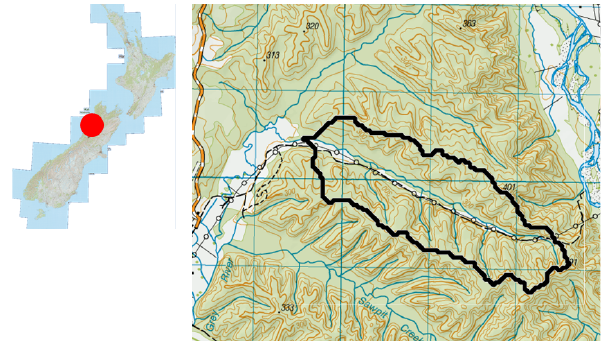
Fig. 4. Discharge, precipitation and potential evaporation data for Fig. 4: Discharge (bottom), precipitation and potential evaporation (top) data for Maimai and Wollefsbach catchments (dis- Maimai and Wollefsbach catchments (discharge = bottom blue line, charge = blue line, Precipitation = blue bars, potential evaporation = red line). Note that the potential evaporation is presented precipitation = top blue bars, potential evaporation = top red line). in mm/day and the discharge and precipitation in mm/hour. The discharge scale for both catchments differs: the discharge in Note that the potential evaporation is presented in mmday − 1 and the Wollefsbach is much lower. the discharge and precipitation in mmh − 1 . The discharge scale for both catchments differs: the discharge in the Wollefsbach is much lower.